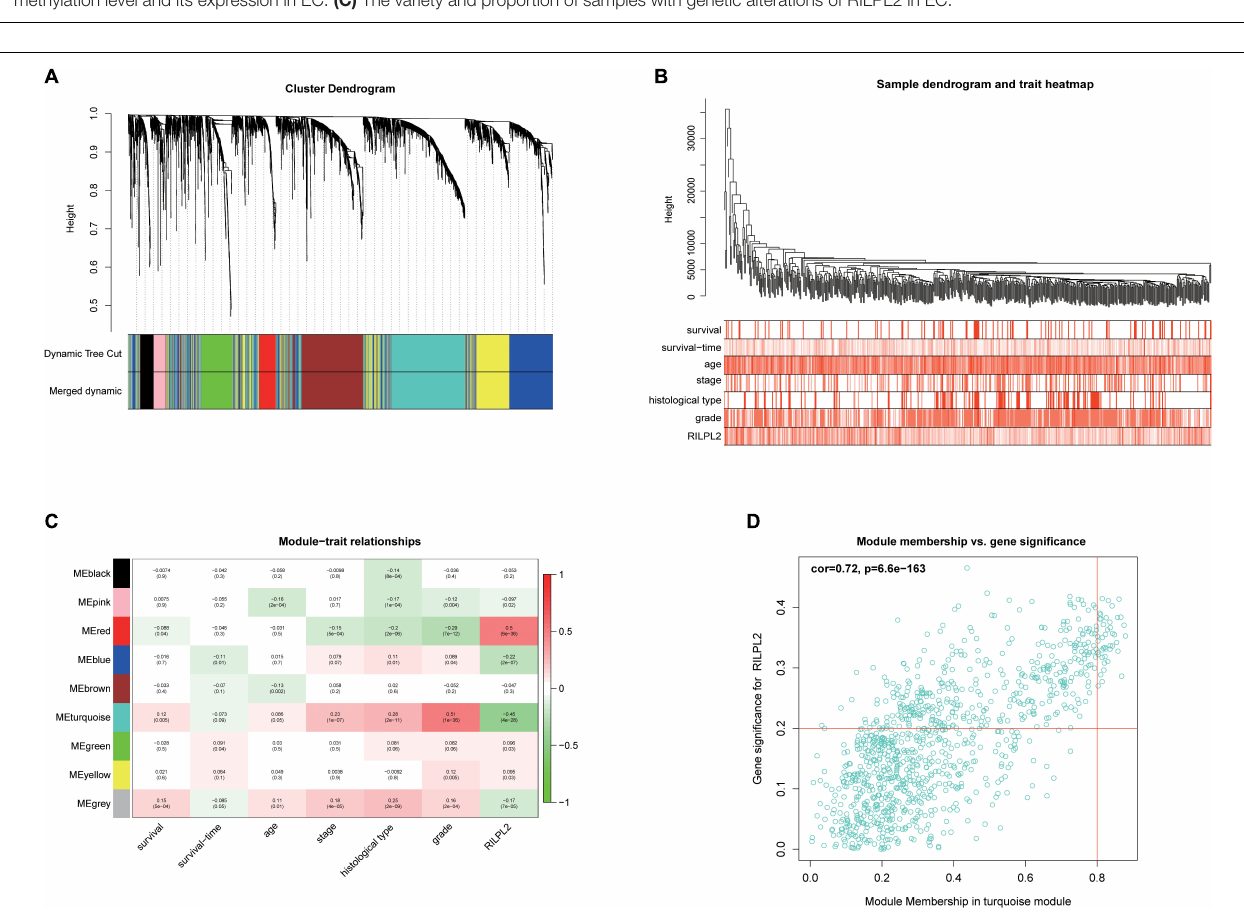
FIGURE 6 | Exploration for genes correlated with RILPL2 in EC. (A) Clustering dendrogram of EC patients from the TCGA dataset. (B) A total of 2,573 DEGs were clustered according to the dissimilarity measure (1-TOM) and were classified into nine modules. (C) A correlation heatmap between module eigengenes and clinical features of EC. (D) Scatter plot of turquoise module